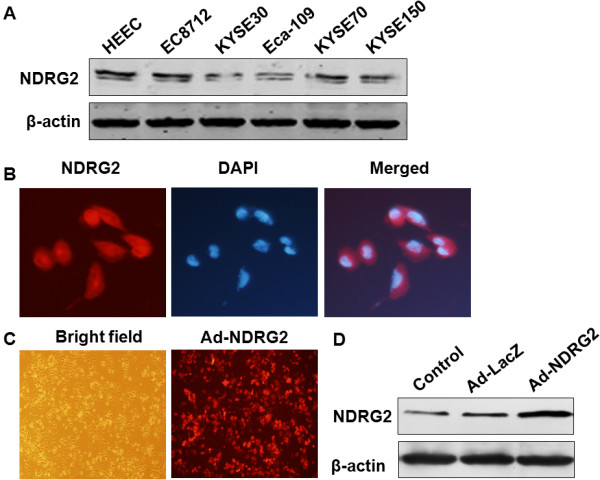
Up-regulation of NDRG2 expression by Ad-NDRG2 in Eca-109 cells. A. HEEC cells (a normal human oesophageal epithelial cell line) and five ESCC cell lines (EC8712, KYSE30, Eca-109, KYSE70 and KYSE150) were collected for protein extraction and analysed for NDRG2 expression using western blot. B. Subcellular localisation of NDRG2 in Eca-109 cells. Eca-109 cells were fixed and incubated with a primary anti-NDRG2 monoclonal antibody and a CY3 secondary antibody. Red fluorescence (NDRG2) was observed in the cytomembrane and cytoplasm of Eca-109 cells. Blue fluorescence indicates DAPI nuclear staining. C. Immunofluorescence showed the efficiency of Ad-NDRG2 infection (red). D. Western blot analysis of NDRG2 in Eca-109 cells infected with Ad-NDRG2. Equal amounts of protein (80 μg/lane) were subjected to western blot analysis as described in the Methods.